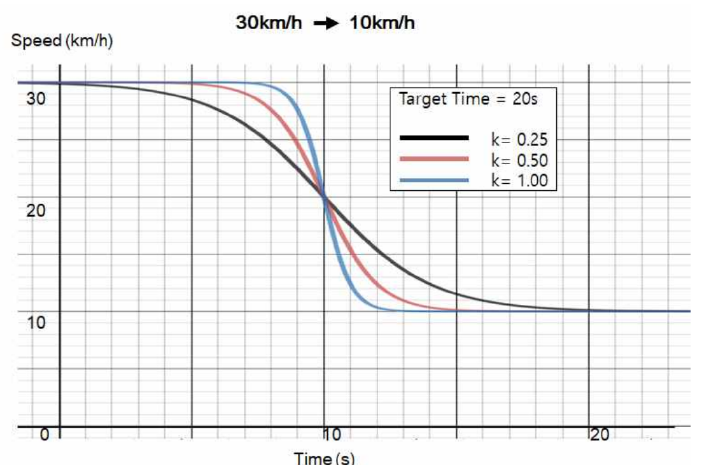
Figure 6. Speed graph for varying values of k as vehicle slows from 30 to 10 km/h. Target time was set to 20 s. When constant k is decreased, the vehicle slowing time